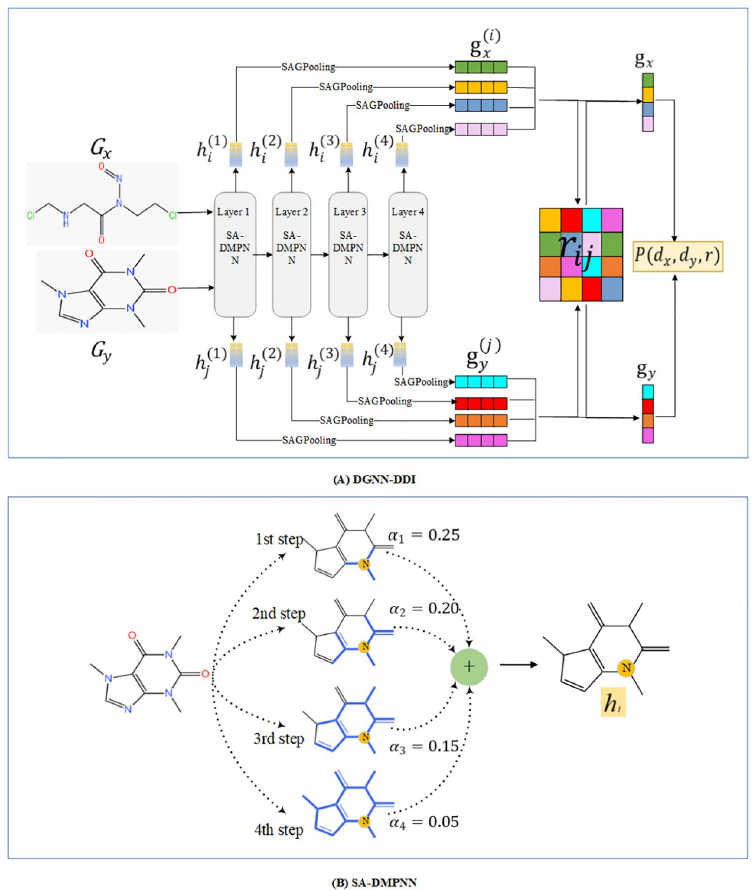
Fig 12. The overview of proposed DGNN-DDI for DDI prediction. (A) The workflow of DGNN-DDI. (B) The SA-DMPNN updates the node-level features with T steps where T is 4 in this example.